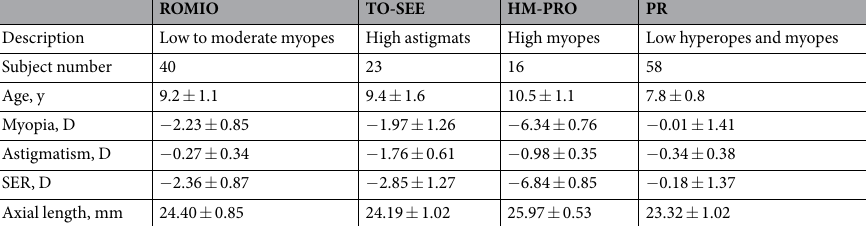
Table 3. Description and baseline demographics (mean ± SD) of analysed subjects (n = 137) from ROMIO 67 , TO-SEE 68 , HM-PRO 69 and PR (a subset of Lee & Cho study) 74 studies. SER: spherical equivalent